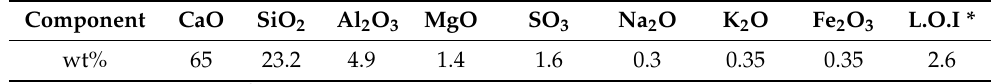
Table 1. Chemical composition of the cement used in this study. Component